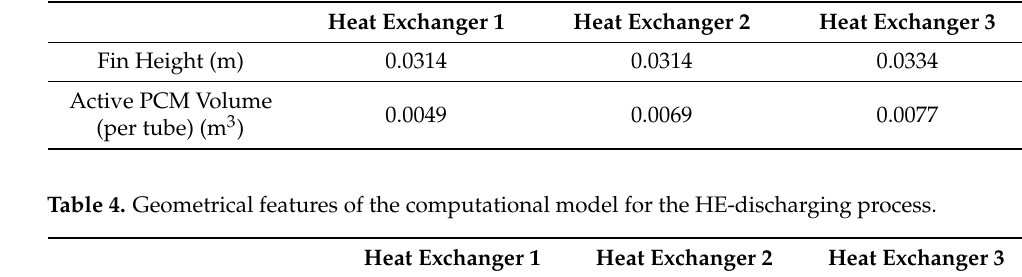
Table 3. Geometrical features of the computational model for the HE-charging process.